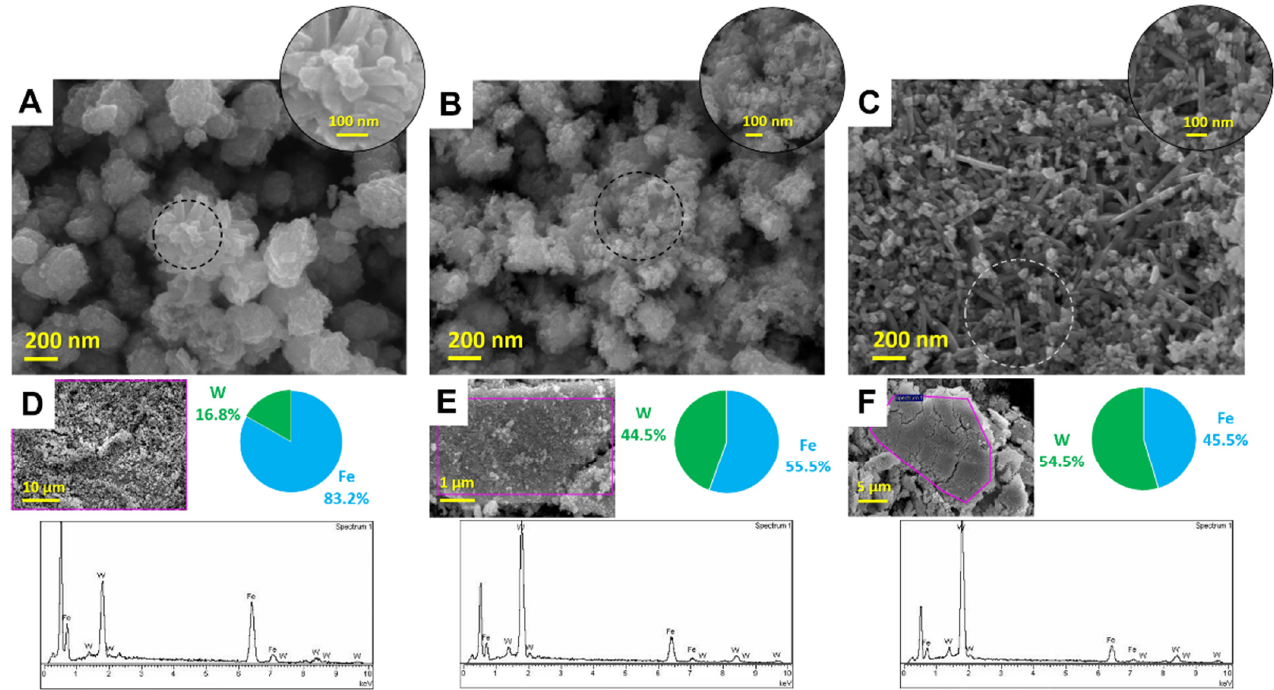
Figure 2. FE-SEM micrograph of ( A ) Fe 3 W 1 ; ( B ) Fe 1 W 1 , and ( C ) Fe 3 W 3 . Corresponding elemental analysis is given in ( D – F